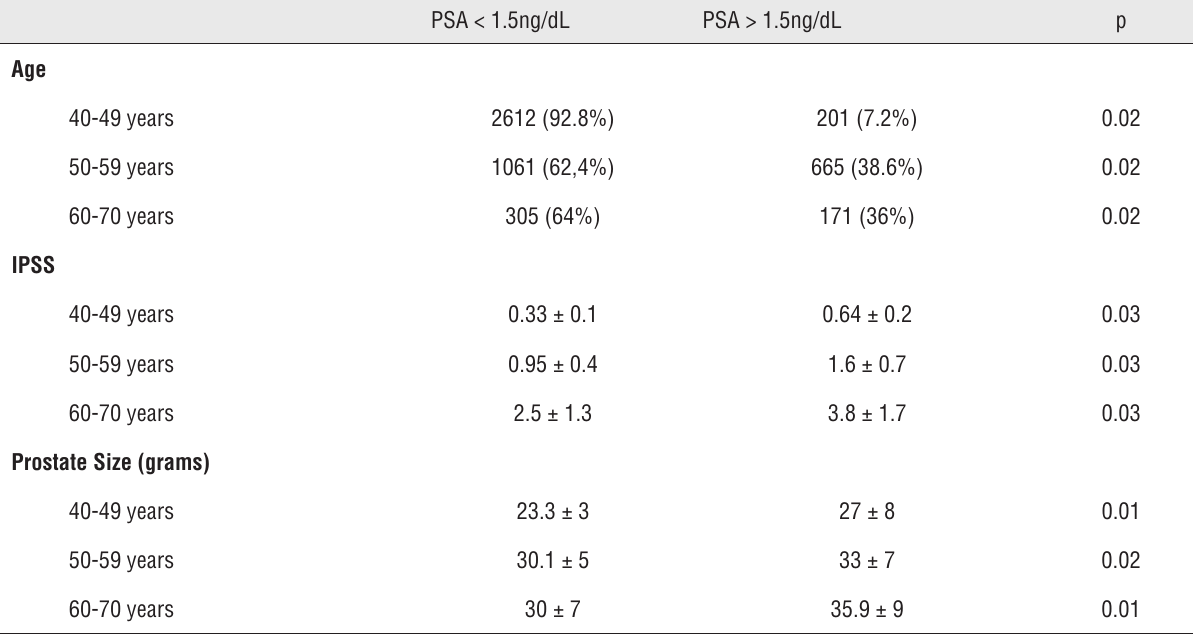
Table 5 - The prevalence of PSA greater or less than 1.5ng/dL and its correlation with IPSS and prostate